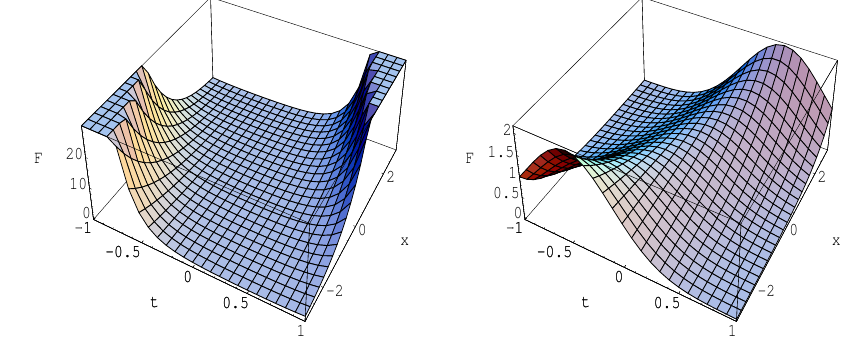
Figure 1. The surface for the solution F ( t , x , y )